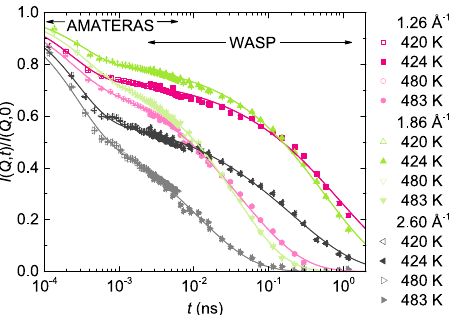
Fig. 6 Joint intermediate scattering functions of CKN covering a broad time window at three representative Q ’ s: (1.26, 1.86, and 2.60) Å − 1 . The data presented by open symbols from t = 0.1 ps to 6 ps are Fourier deconvoluted time-of- fl ight spectra measured on AMATERAS, those presented by solid symbols from t = 2.6 ps to 1.2 ns are the WASP data. The AMATERAS data are measured at T = 420 K and 480 K, and the WASP data are at T = 424 K and 483 K. These two sets of data match in the overlapping time range without any arti fi cial adjustment. The solid lines represent fi t to Eq. (1) of the joint intermediate scattering functions. Error bars represent one standard error and where not seen they are smaller than the symbol size. Source data are provided as a Source Data fi